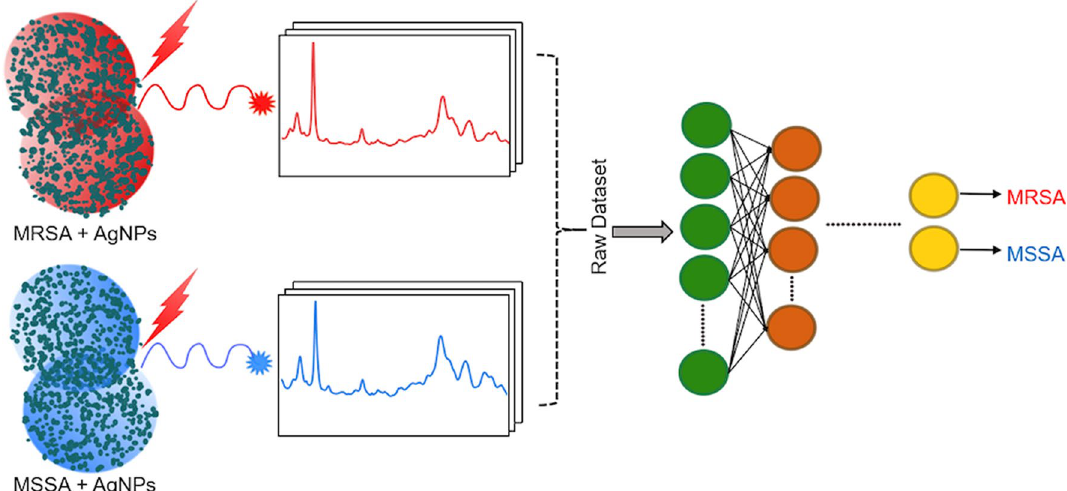
Figure 6. The graphical abstract of the study representing the main steps of the study consisting of AgNPs are mixed seperately with MRSA and MSSA and obtaining SERS spectra which are processed with deep learning techniques to distinguish the